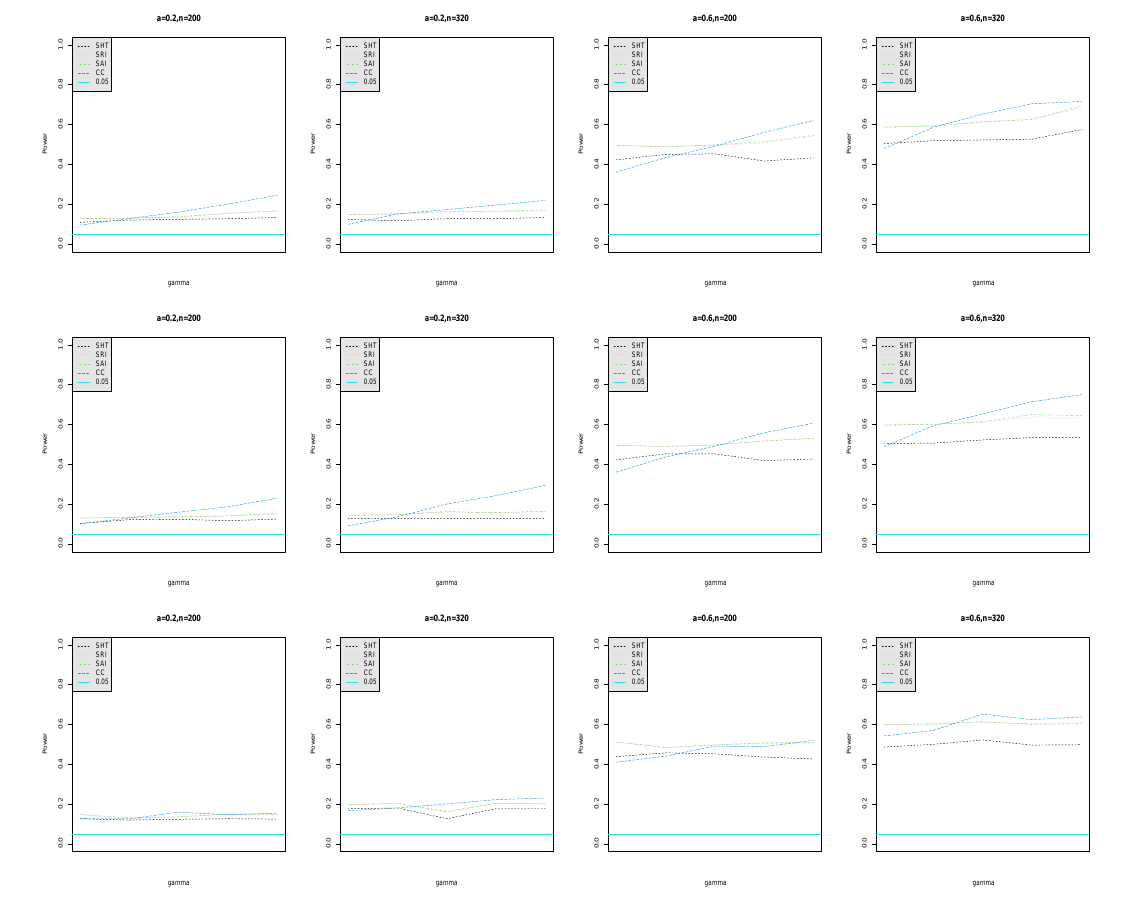
Figure A8. SHT, SRI, SAI and CC represent empirical powers evaluated from IPW, regression imputation, AIPW and CC methods against γ for missingness data mechanism models E2 (the first row), E3 (the middle row) and E4 (the last row) together with ( a , n ) = (0.2,200), (0.2,320), (0.6,200) and (0.6,320), respectively, under the unbalanced designs with n E : n R : n P =